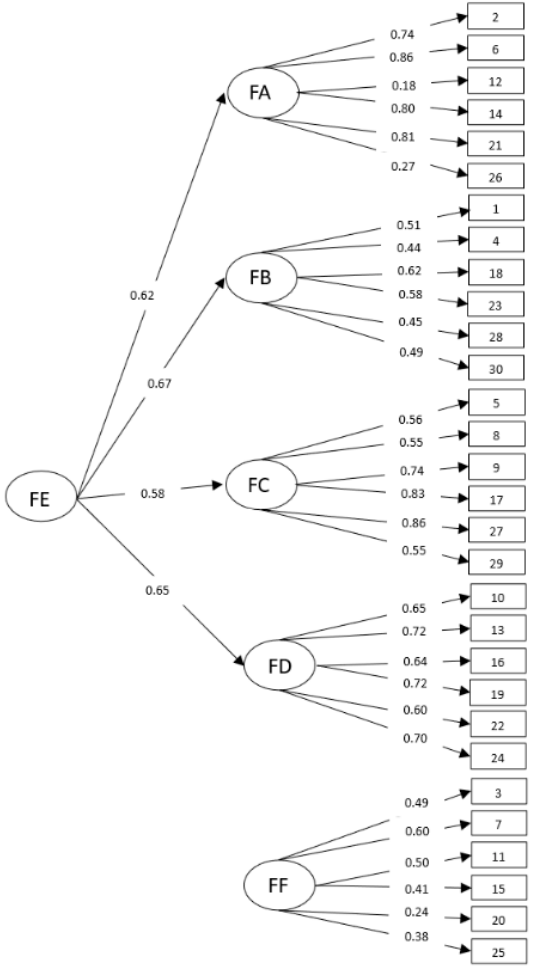
Figure 1. Confirmatory Factor Analysis (CFA) final model of the Spanish version of the Bar-On Emotional Quotient Inventory: (EQ-i): Youth Version (YV) (S). Note: FA = Intrapersonal scale; FB = Interpersonal scale; FC = Stress Management scale; FD = Adaptability scale; FE = EI Total scale; FF = Positive impression scale.